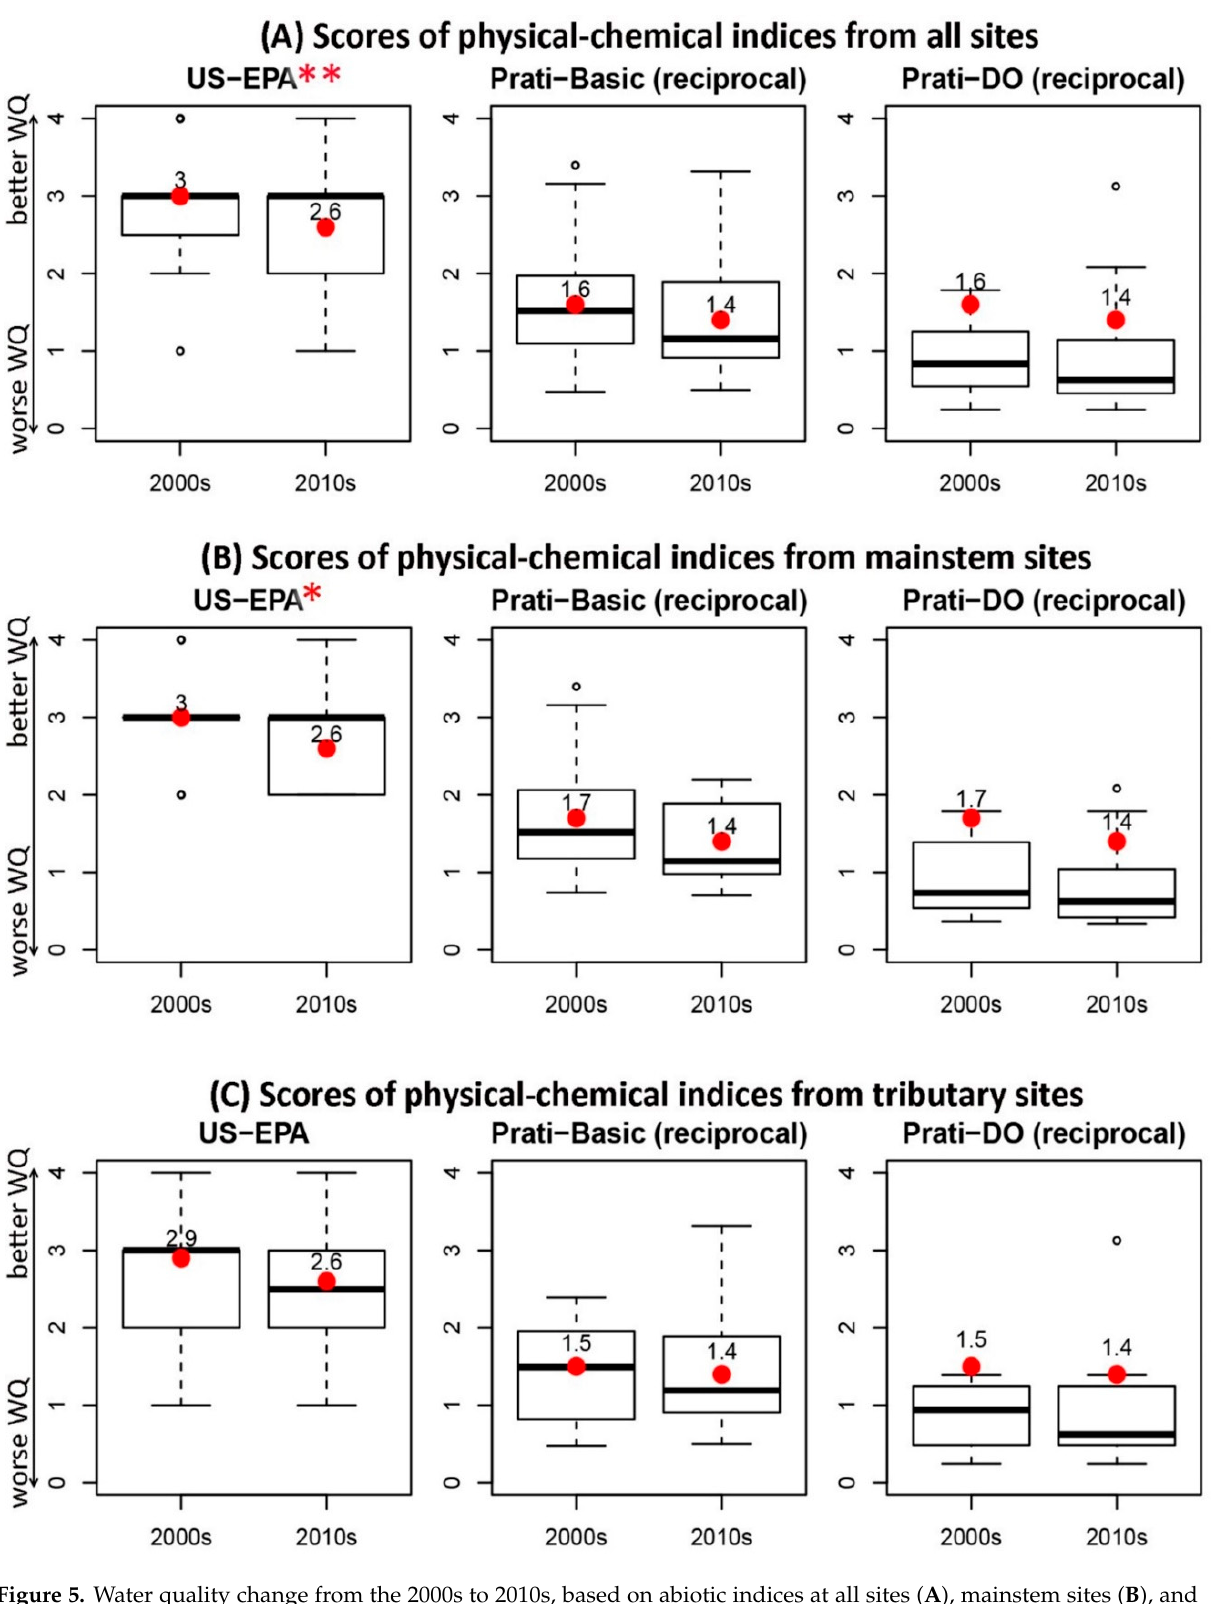
Figure 5. Water quality change from the 2000s to 2010s, based on abiotic indices at all sites ( A ), mainstem sites ( B ), and tributary sites ( C ). * and ** (in red) indicate statistically significant differences at p < 0.05, and p < 0.01, respectively. Red dots indicate the mean value for each index. WQ: water quality.